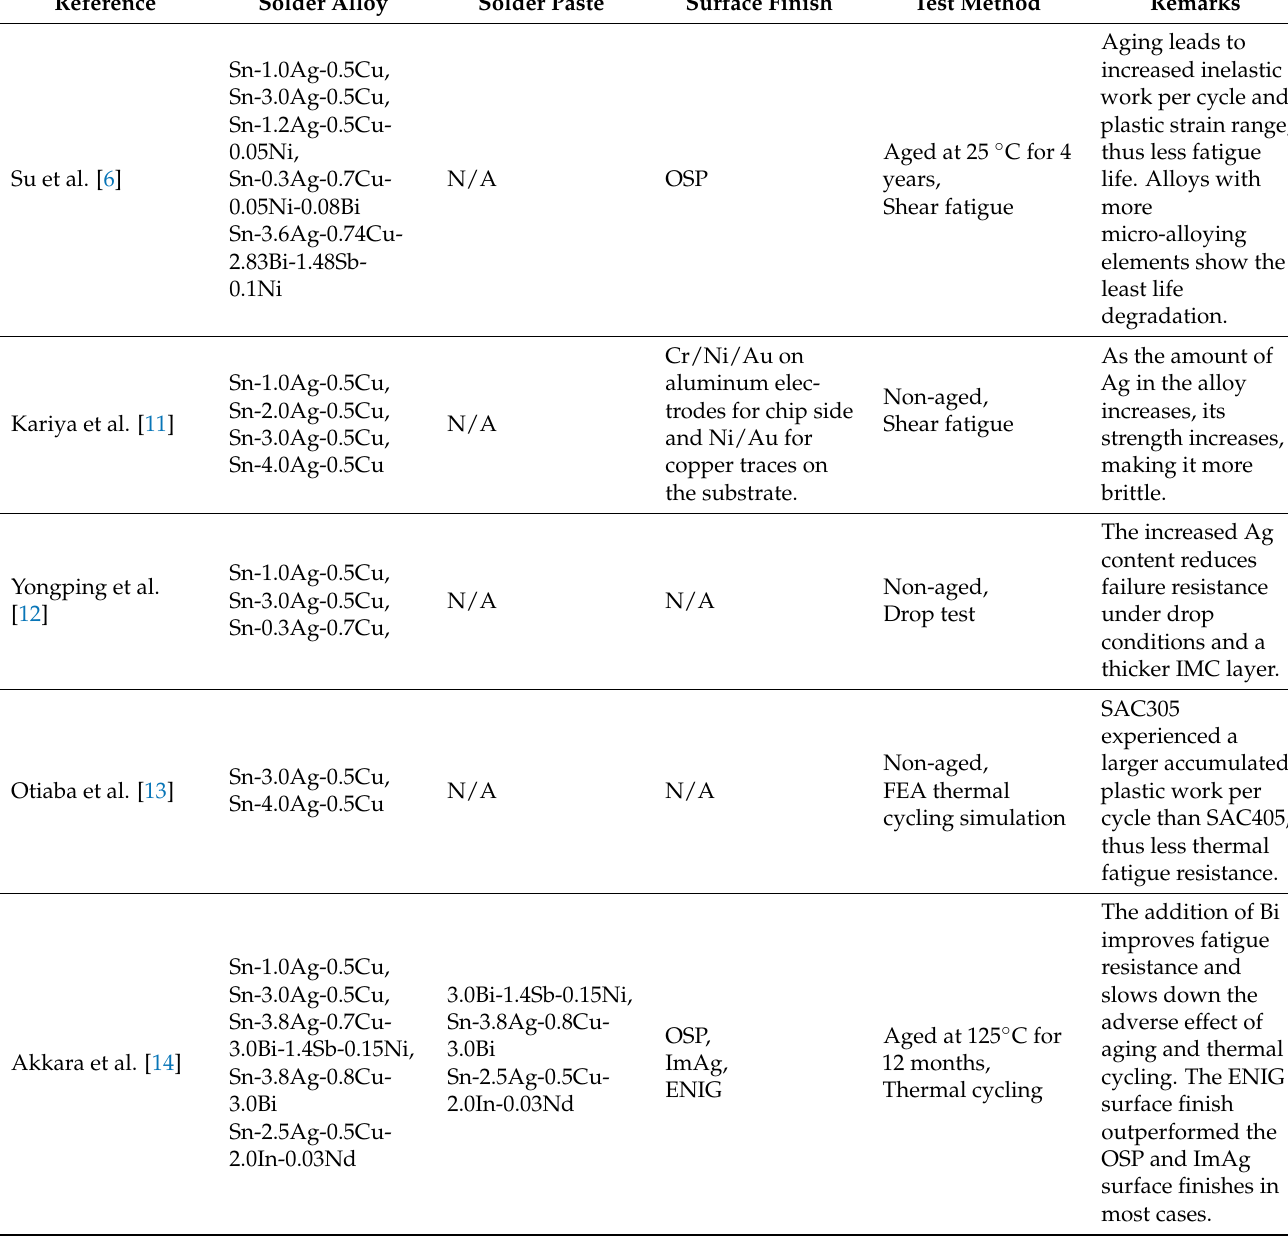
Table 1. Comparison of current study with other researchers as described in the